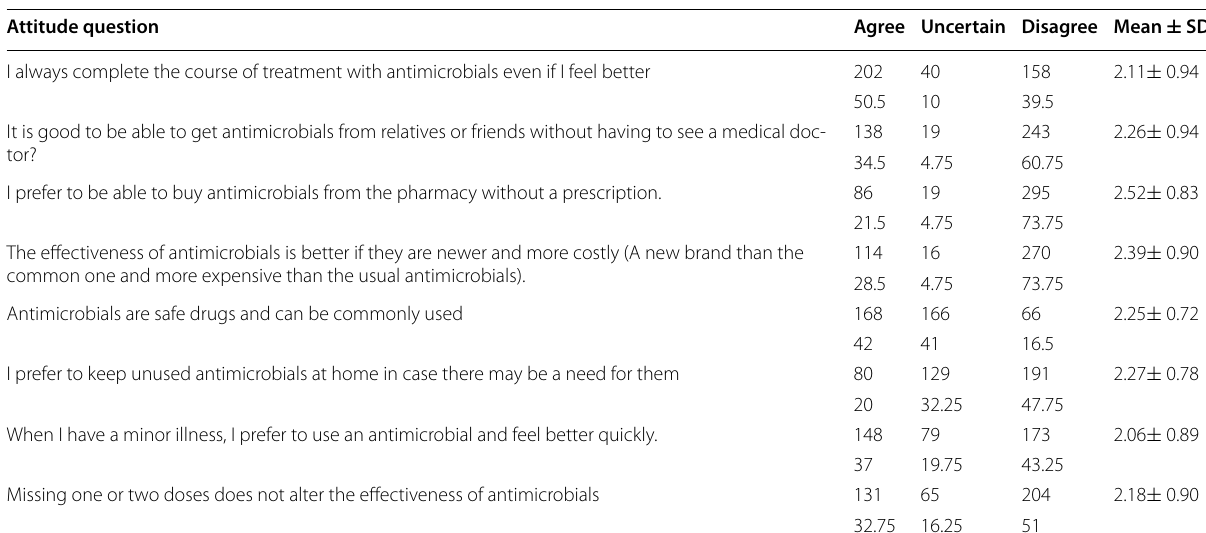
Table 3 Attitude toward antimicrobial usage and resistance Attitude